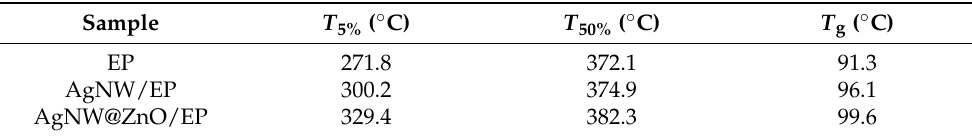
Figure 10. ( a ) TG and ( b ) DSC curves of EP, AgNW/EP, and AgNW@ZnO/EP composites. Table 2. TG and DSC data of EP, AgNW/EP, and AgNW@ZnO/EP composites.